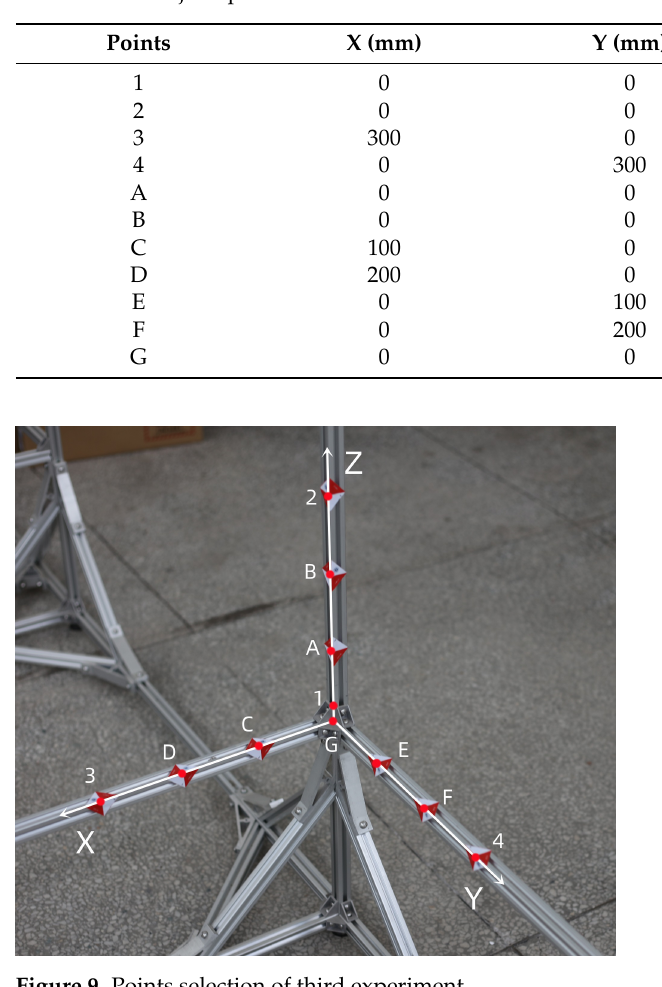
Table 12. The object space coordinates.